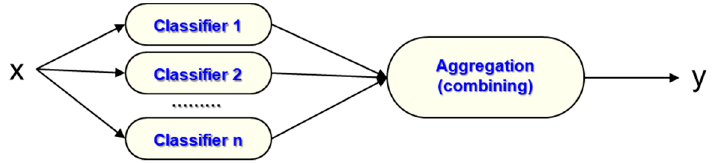
Figure 7. A diagram presenting the idea of using ensemble classifiers. Source: own elaboration.